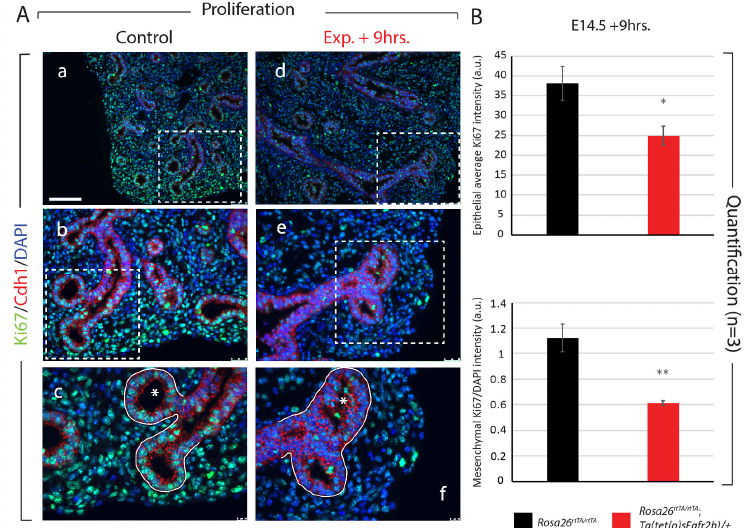
Figure 3. Analysis of proliferation in E14.5 lungs after 9 hours of Fgfr2b inhibition. (A) Control (a–c) and experimental (d–f) lungs were stained for Ki67 and Cdh1 to assess proliferation in the epithelial and mesenchymal compartments (separated by the white line in c and f). Note the multilayered and disorganized epithelium invading the lumen of experimental lung buds (compare asterisks in c and f), which is a hallmark of Fgfr2b inhibition at E12.5 as well [13]. Scale bar: (a, d) 100 µm, (b, e) 50 µm, (c, f) 20 µm. (B) Quantification of Ki67 expression showing a significant decrease in proliferation in both the epithelial and mesenchymal compartments. (a.u. = arbitrary units) (* p -value < 0.05, ** p -value < 0.01).